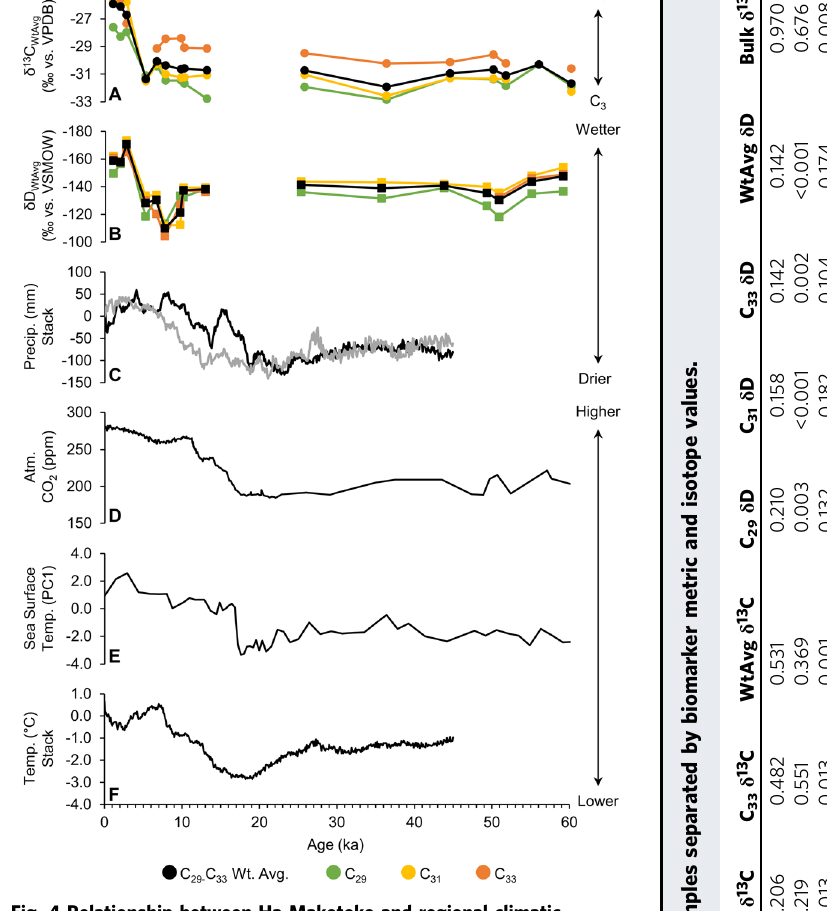
Fig. 4 Relationship between Ha Makotoko and regional climatic parameters. A C 29 -C 31 n -alkanes δ 13 C. B C 29 -C 31 n -alkanes δ D. C Southern African precipitation stack of the wettest quarter for northern (grey) and central/eastern (black) SRZ 34 . D Global atmospheric CO 2 concentrations compiled from Dome C and Vostok ice cores, Antarctica 116 – 118 . E Principal component of SST records from MD96-2048 32 . F Mean annual southern African temperature stack 34